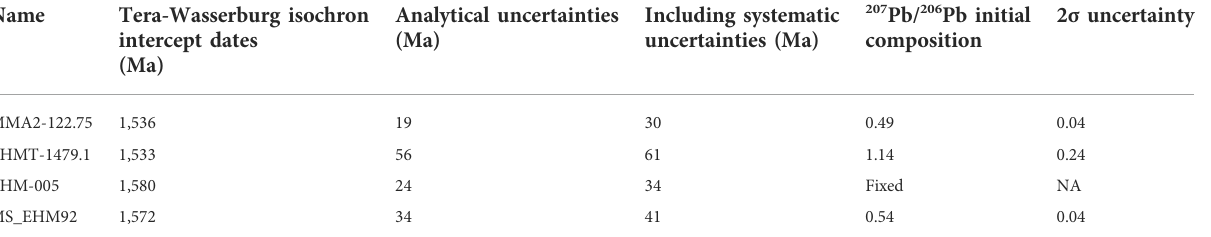
TABLE 2 Apatite U-Pb